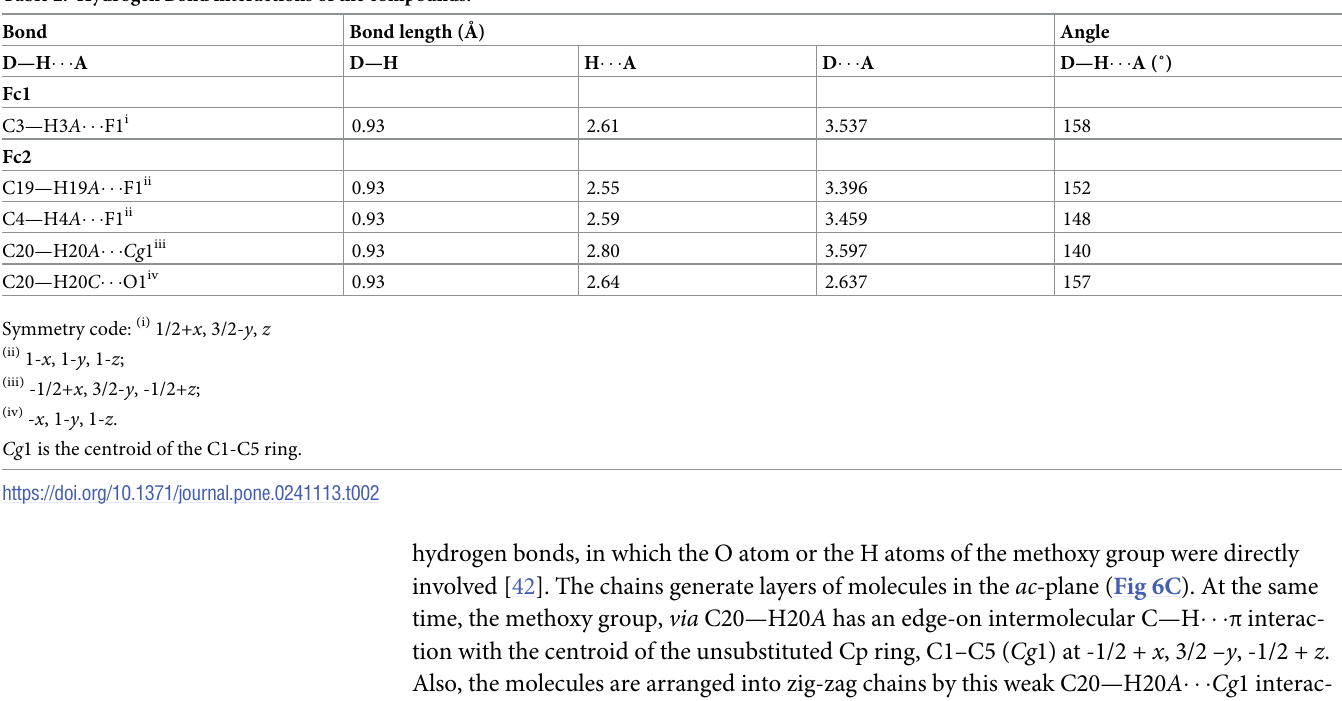
Table 2. Hydrogen Bond interactions of the compounds. Bond